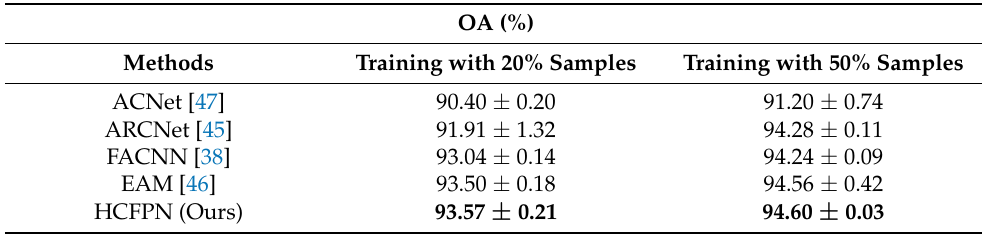
Table 4. Overall accuracy (%) of HCFPN and the comparison methods when trained on the WH- MAVS dataset using a proportion of 20% and 50% of the